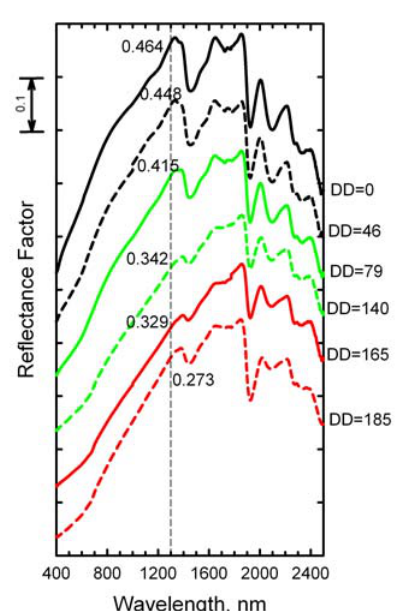
Figure 4. Spectral reflectance of wheat straw at selected decomposition days (DD). The spectra are displaced vertically to avoid overlap. Reflectance at 1,300 nm is provided for each spectrum.